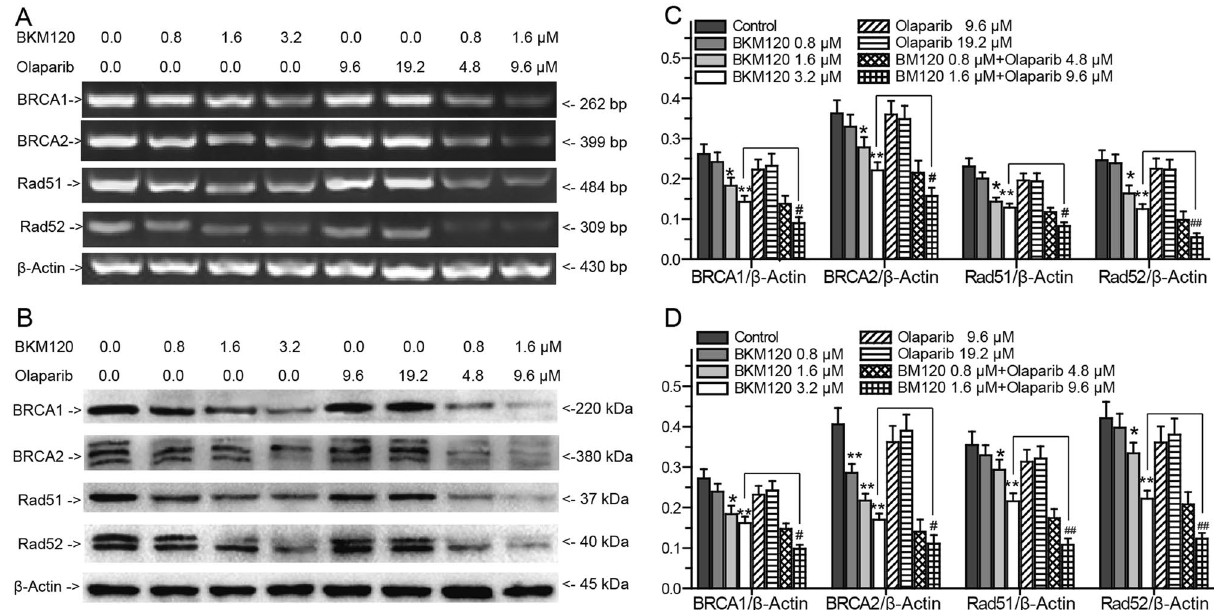
Figure 4. Effects of BKM120 and olaparib on the repair factors of DNA DSBs. Effects of BKM120, olaparib, and a combination of BKM120 with olaparib on the expressions of BRCA1, BRCA2, Rad51 and Rad52 in MDA-MB-231 cells analyzed by ( A ) RT-PCR and ( B ) western blots. Relative intensity expression obtained from the corresponding ( C ) RT-PCR and ( D ) western blots. Error bars represent SEM from the mean of three separate experiments. * P < 0.05 and ** P < 0.01 compared to control, # P < 0.05 and ## P < 0.01 compared to 3.2 μM BMK120-treated